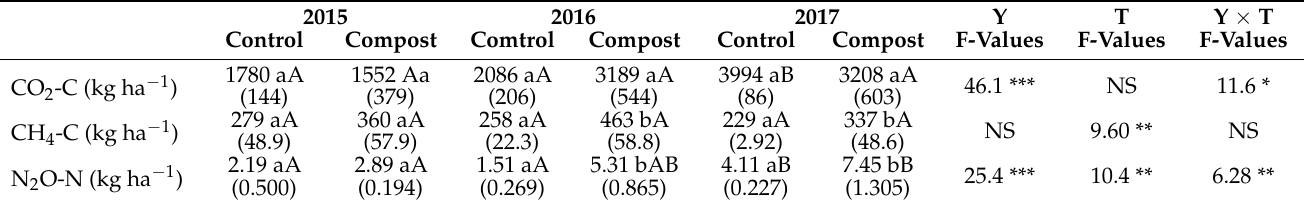
Table 3. Effect of the different management systems on the cumulative emission of CO 2 , CH 4 , and N 2 O (kg ha − 1 ) during the rice cultivation cycle. Mean and standard error of 3